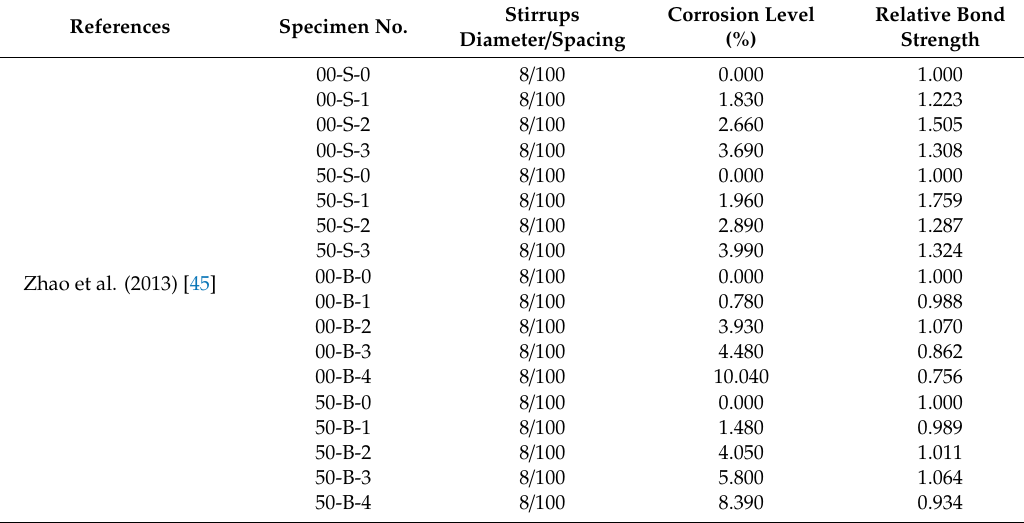
Table A2. Dataset for cases with stirrups and variable with only stirrups diameter to spacing ratio and corrosion level ( n =